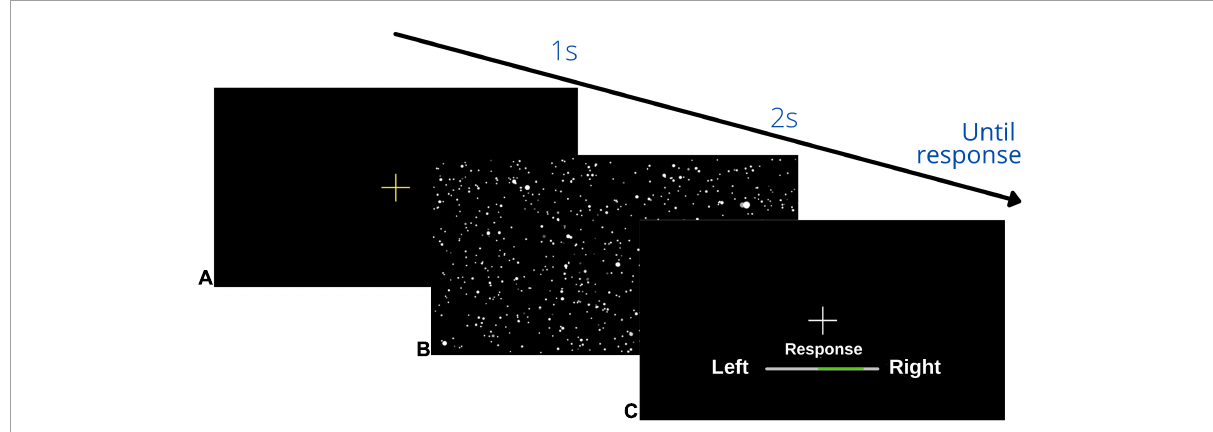
FIGURE3 Schematic overview of visual display during the psychophysical heading task: (A) initial yellow fixation cross to signal the start of the trial, (B) heading movement: the starfield was present for the visual, bimodal and training trials, but during the vestibular condition the display was black, (C) response screen: participants pressed and held their response until the bar on the display was filled in green in the direction of their heading judgment (left/right) (2 s). This sequence repeated until the end of the block.